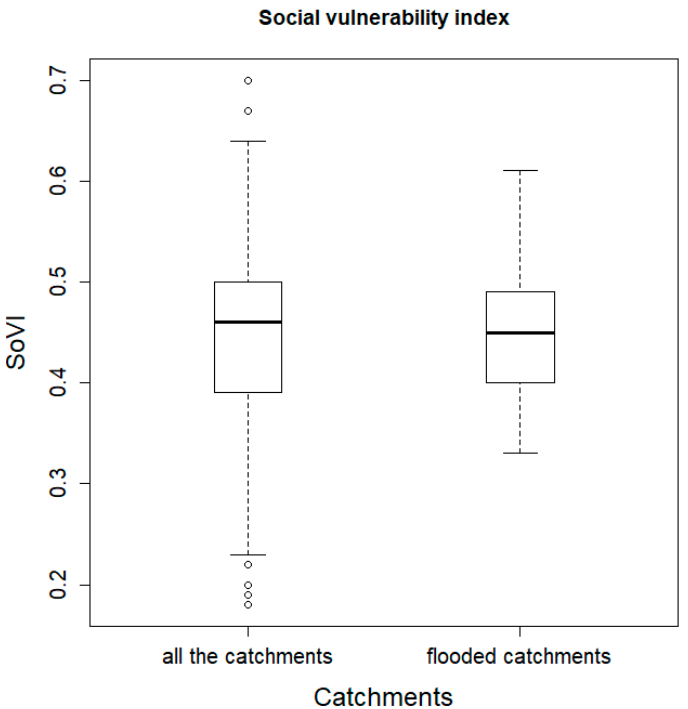
Figure 8. Boxplot of the SoVI values for all the catchments and flooded catchments.